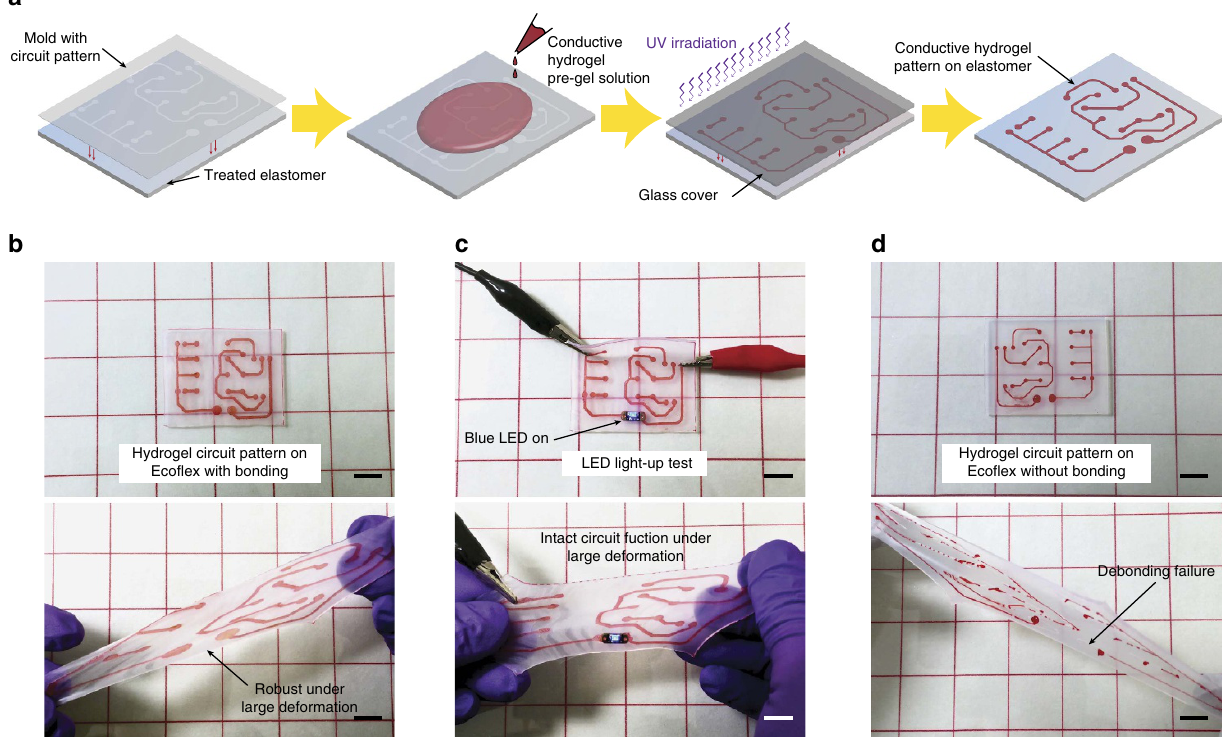
Figure 6 | Stretchable hydrogel circuit board patterned on elastomer. ( a ) Schematic illustration of fabrication procedure for conductive hydrogel circuit patterned on flexible elastomer substrate. ( b ) Ionically conductive PAAm-alginate hydrogel circuit bonded on an Ecoflex elastomer substrate using the proposed method is robust under large deformation without visible failure. ( c ) The hydrogel circuit board connected with an AC power source can light up LED, and it can maintain its electrical functionality even under severe deformation. ( d ) A hydrogel circuit bonded on Ecoflex elastomer without benzophenone treatment delaminates and fails under deformation, due to the weak hydrogel–elastomer bonding. Scale bars, 10mm ( b – d